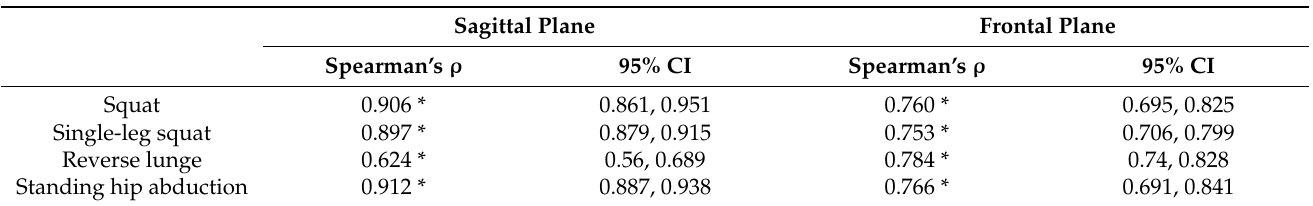
Table 2. Concurrent validity of head angle determined with the earbud-type IMU sensor, compared with the 3D motion